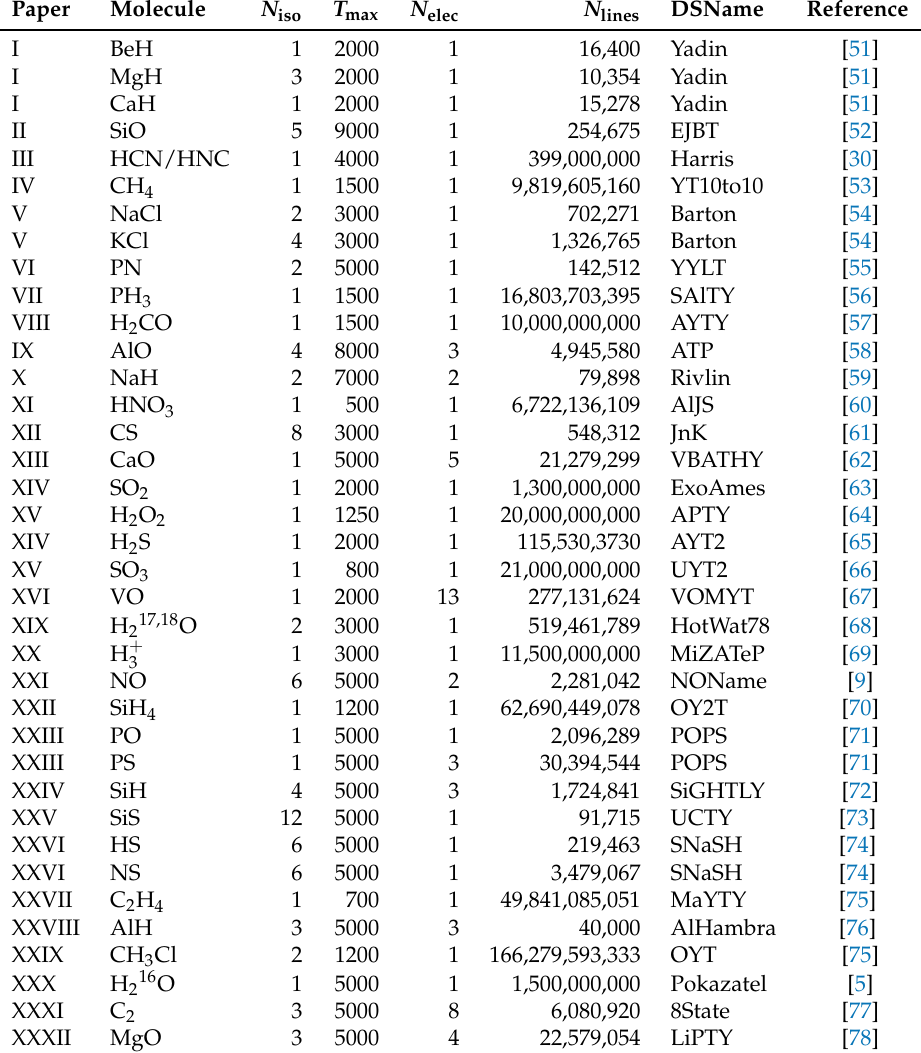
Table 2. Datasets created by the ExoMol project and included in the ExoMol database